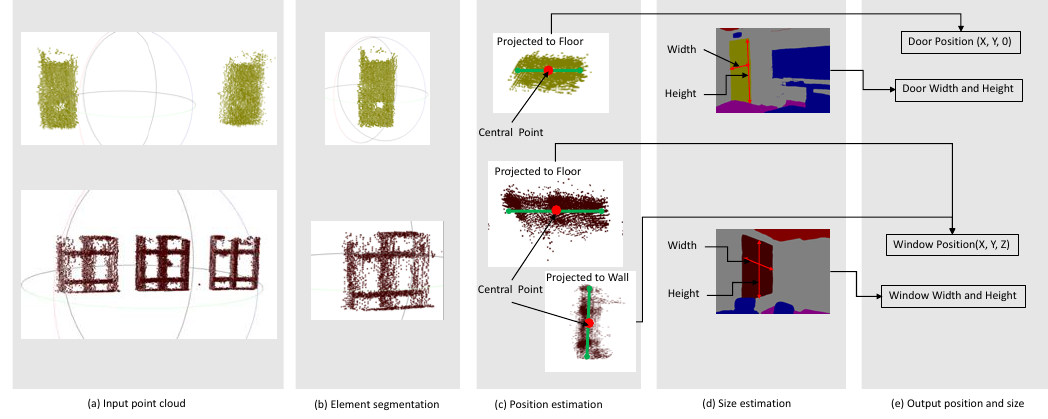
Figure 12. Position and size extraction of door and windows.